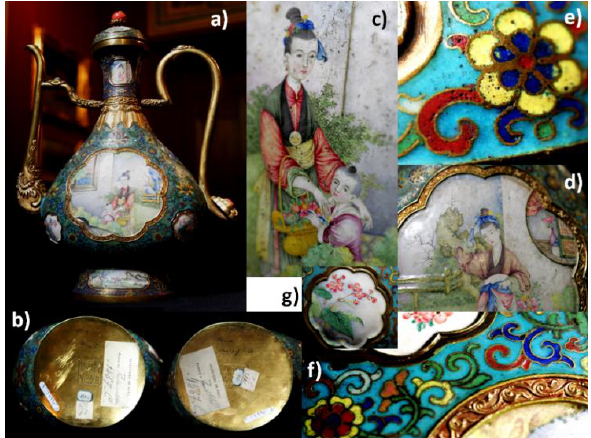
Figure 2. Chinese enamelled ewers with cloisonné and painted decor (F1467.1 and F1467.2): ( a ) whole view, ( b ) Qianlong marks on the back face; ( c , d , g ) details of painted decor; ( e , f ) details of cloisonné décor.